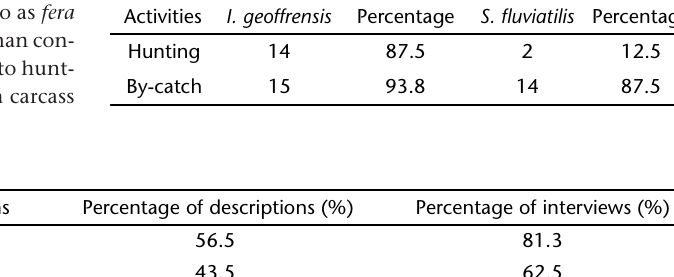
Table III. Illegal activities of fishery on river dolphins. Activities I.